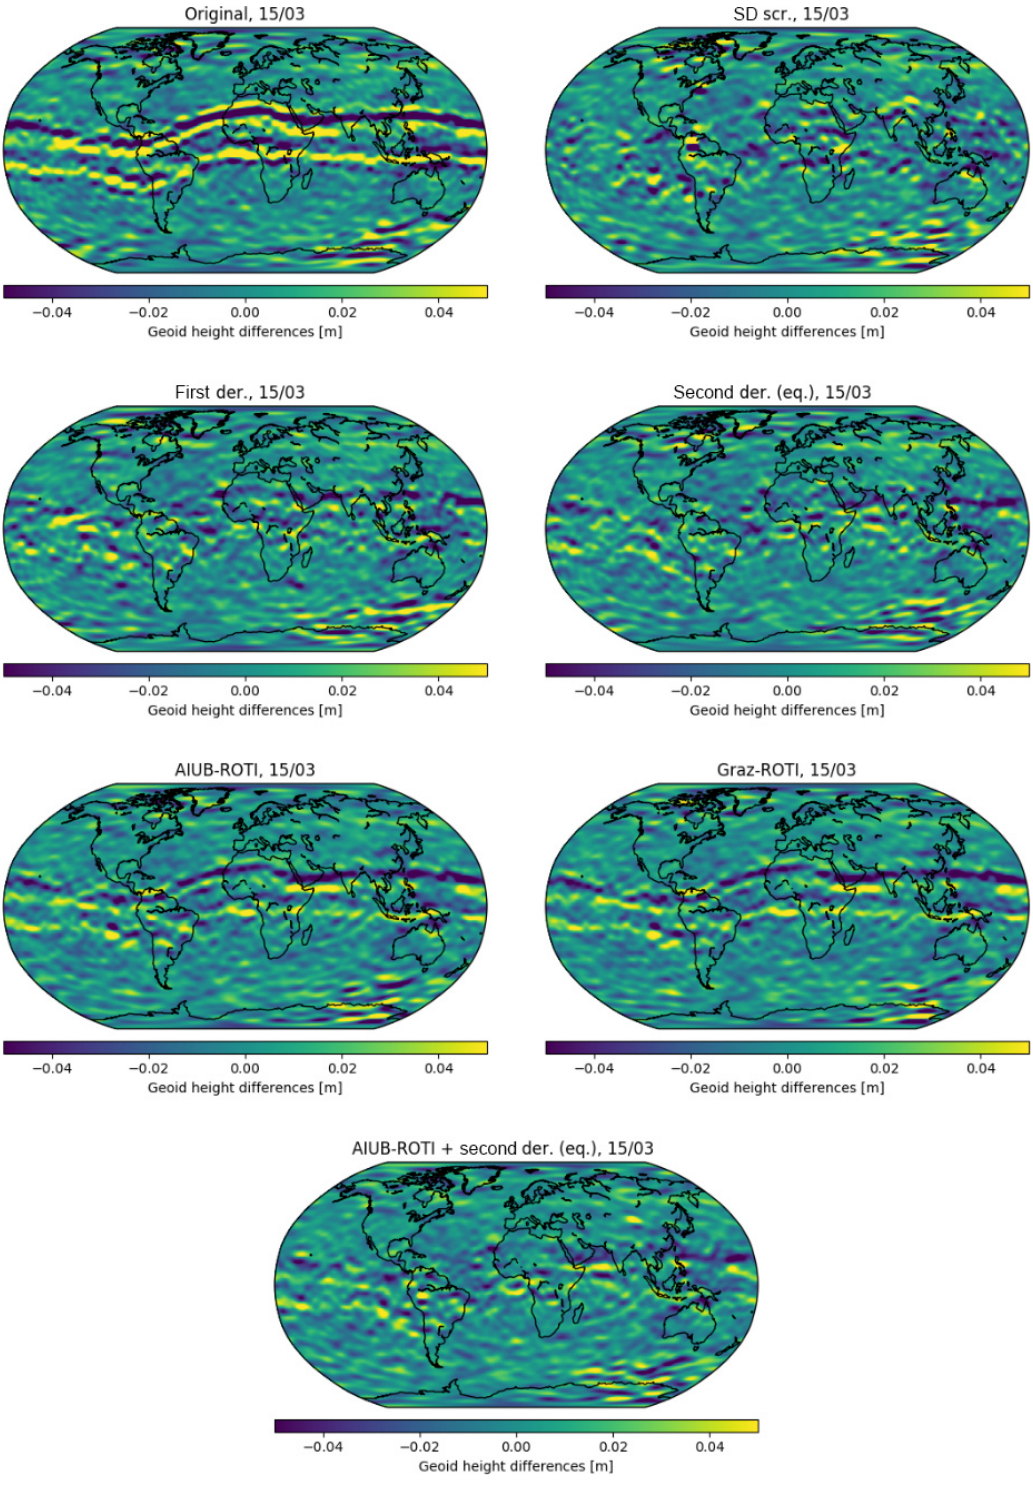
Figure 8. Geoid height differences between the monthly Swarm A gravity field to the corresponding JPL-GRACE-RL06 solution for March 2015. Gravity field differences were computed up to degree 70. The second derivative (eq.) based weighting was limited to the equatorial